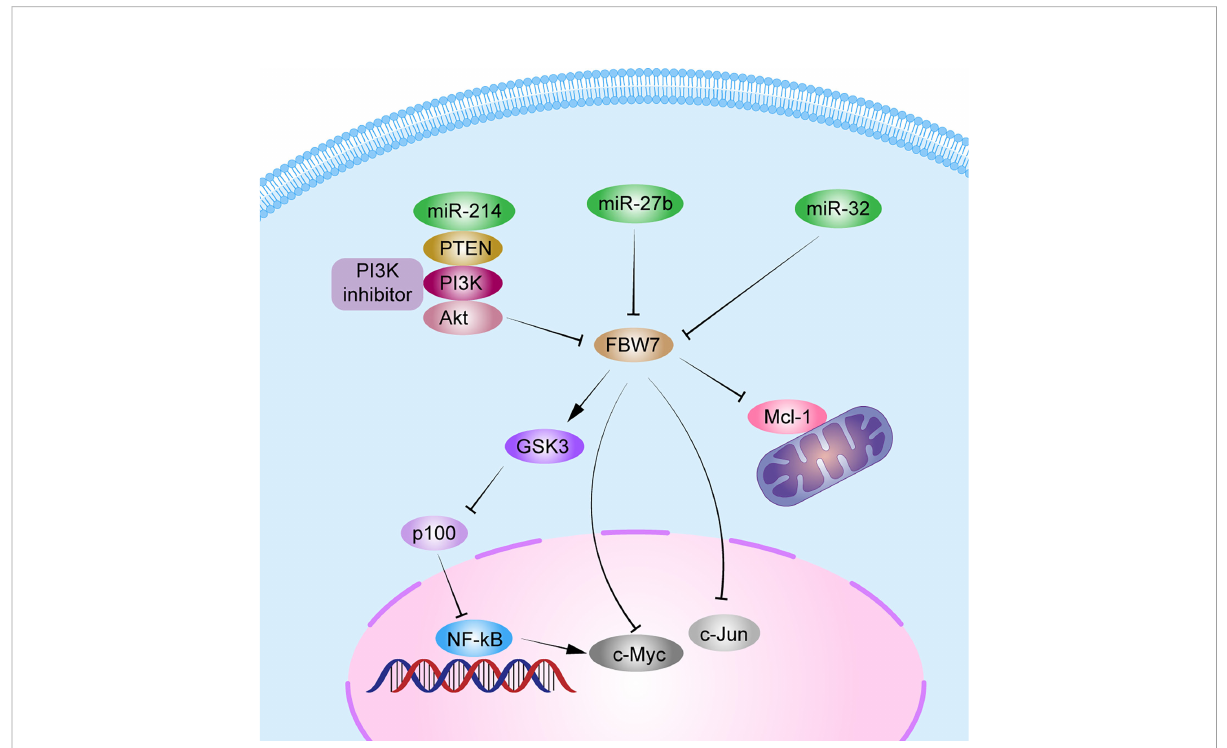
FIGURE 3 Schematic diagram of FBW7-mediated oncogene and signaling pathway in multiple myeloma. 1) FBW7 could target nuclear phosphorylation of p100 by GSK3 b for degradation through ubiquitination, and subsequently activate the NF- k B pathway to promote MM cell proliferation. 2) miRNAs, such as miR-32, miR-27b, and miR-214, block degradation of Mcl-1, c-Myc, and c-Jun by FBW7 directly or indirectly by PTEN/AKT/ GSK3 pathways to induce cell proliferation and apoptosis